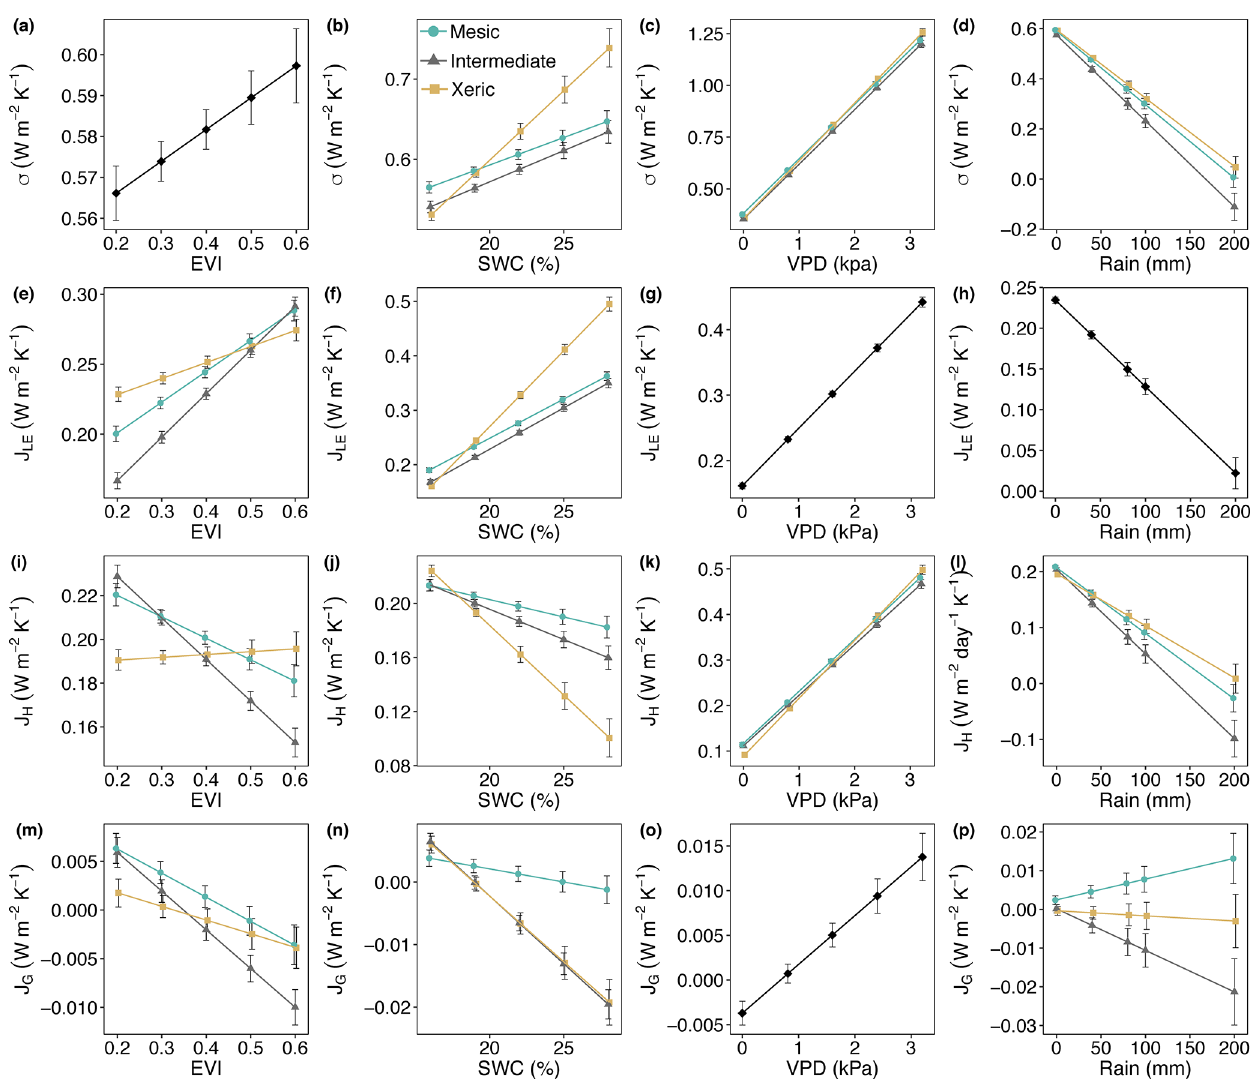
Figure 6. Least squares mean predicted values from mixed models of (a–d) entropy production ( σ ) and entropy fluxes of (e–h) latent energy ( J LE ), (i–l) sensible heat ( J H ), and (m–p) ground heat ( J G ) by site and (a, e, i, m) enhanced vegetation index (EVI), (b, f, j, n) soil water content (SWC), (c, g, k, o) vapor pressure deficit (VPD) and (d, h, l, p) rain. For (g) , (h) and (o) the interaction with site was not significant, as signified by a single black line. Error bars represent